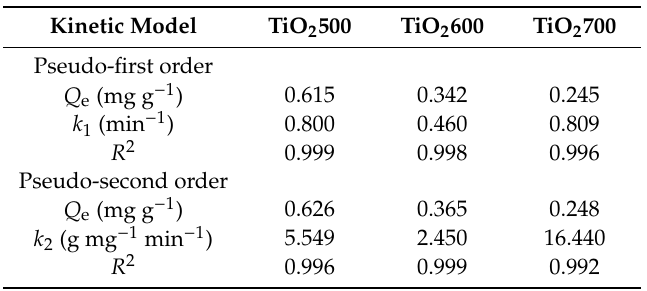
Table 3. Parameters of Rhodamine B dye adsorption kinetics for the obtained fibrous TiO 2 samples.